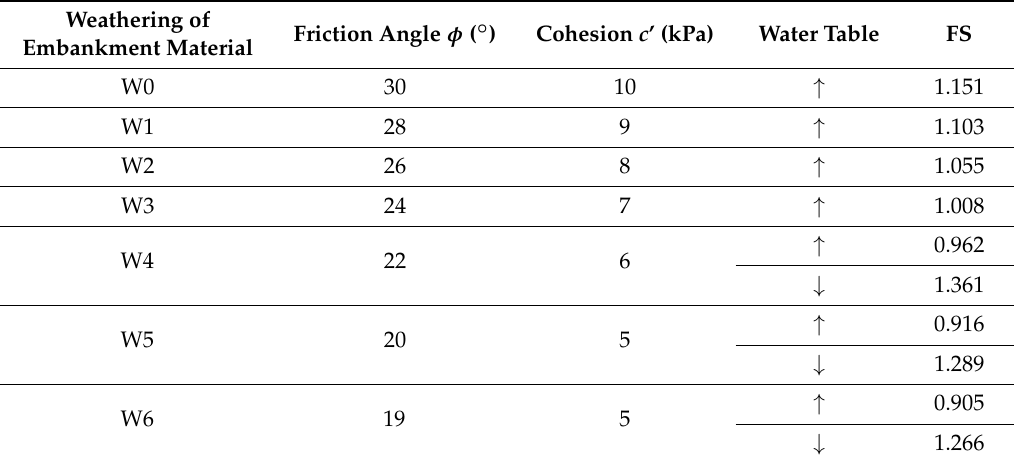
Note: ↑ —High water table, close to the topographic surface; ↓ —Low water table (water table located 3–4 m below the topographic